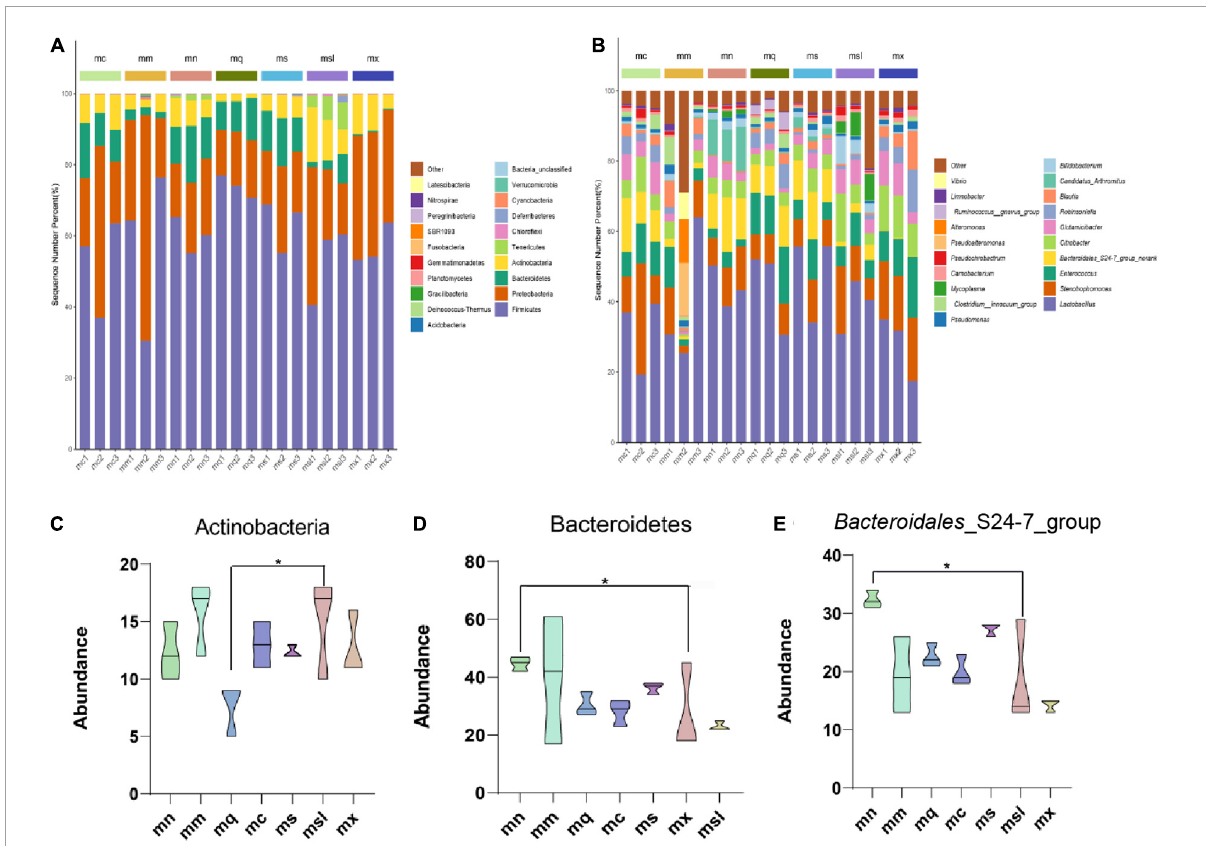
FIGURE4 Relative abundance of the gut microbiota at the phylum and genus. (A) Intestinal mucosal microbiota composition in the phylum level. (B) Intestinal mucosal microbiota composition in the genus level. (C–E) Phylum and genus levels of dominant bacteria (Data were mean ± SD, One-way ANOVA with LSD or rank sum test with Kruskal-Wallis, * p < 0.05). mn, Control group; mm, Model group; mq, QWBZP group; ms, QWBZP + Sucrose group; mc, QWBZP + Saccharinn group; mx, QWBZP + Xylitol group; msl, QWBZP + Sorbitol